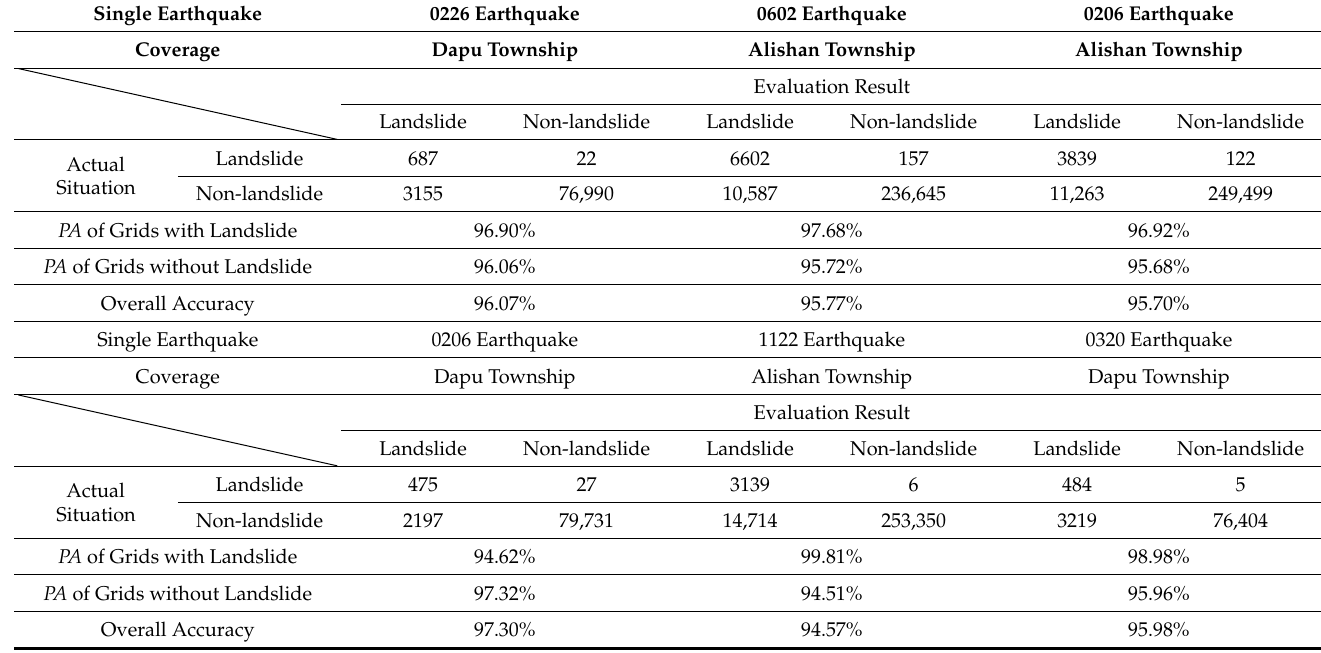
Table 9. Evaluation accuracy of single earthquake-induced landslide